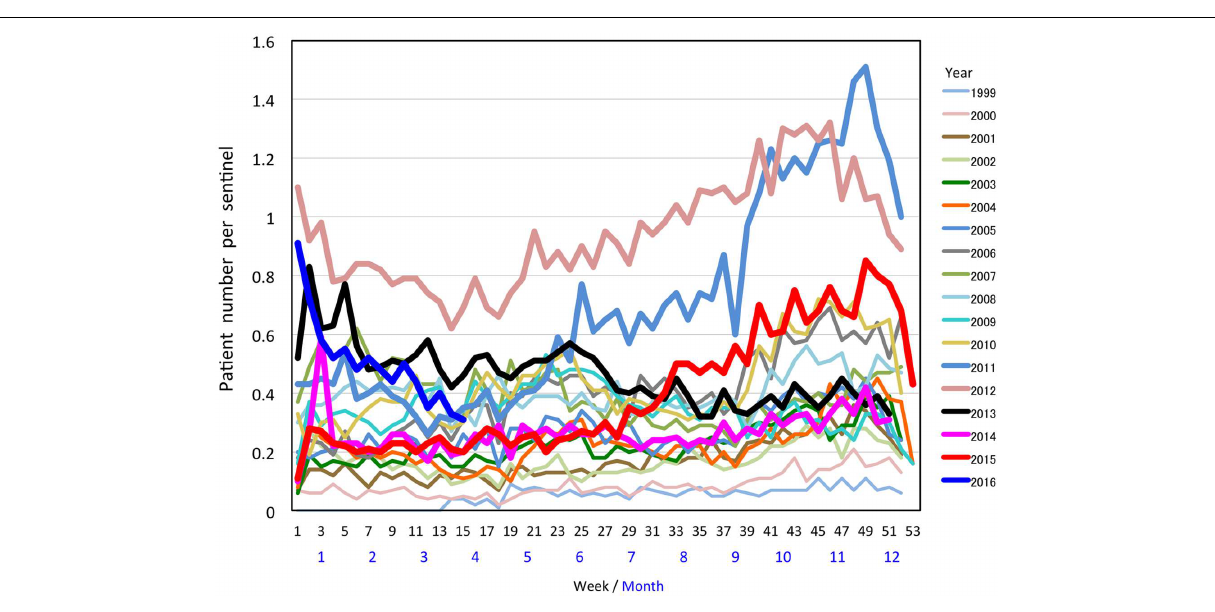
Frontiers in Microbiology |